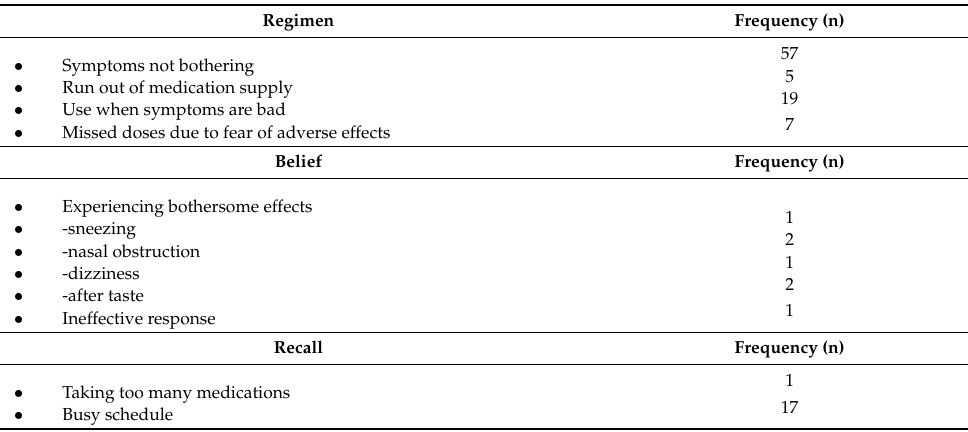
Table 6. Barriers towards adherence to intranasal corticosteroids